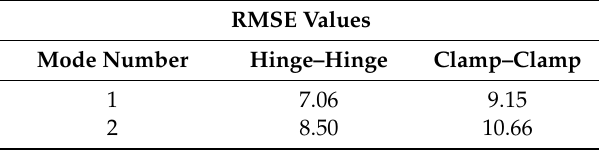
Table 3. R oot-mean-square error (RMSE) values for initial numerical models for two mode shapes. Table 3. Root-mean-square error (RMSE) values for initial numerical models for two mode